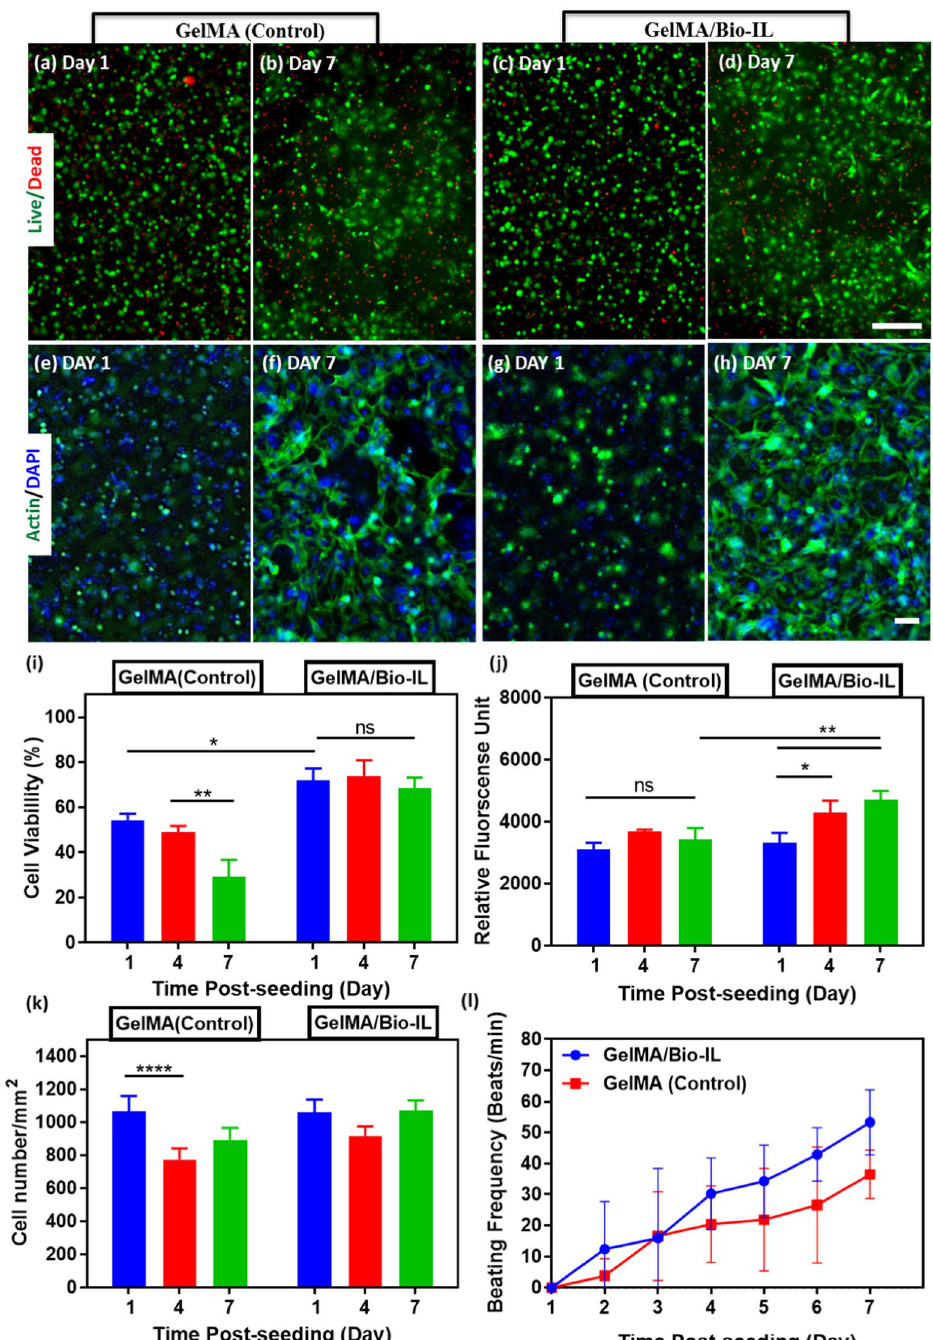
Figure 5. In vitro 3D encapsulation of cardiomyocytes (CMs) and cardiac fibroblasts (CFs) in GelMA/Bio-IL hydrogels. CMs and CFs (2:1 ratio) were 3D encapsulated inside visible light-crosslinked GelMA (control) and GelMA/Bio-IL hydrogels. Representative live/dead images from CMs/CFs encapsulated in GelMA (a , b) and GelMA/Bio-IL (c , d) hydrogels at days 1 and 7 post-encapsulation. Representative F-Actin/DAPI fluorescent images of CMs/CFs encapsulated in GelMA (e , f) and GelMA/Bio-IL (g , h) hydrogels, at days 1 and 7 post- encapsulation (scale bar = 200 μ m). (i) Quantification of cell viability for 3D encapsulated CMs/CFs at days 1, 4, and 7 post-encapsulation. (j) Quantification of metabolic activity, relative fluorescence units (RFU), using PrestoBlue assay at days 1, 4, and 7 post-encapsulation. (k) Quantification of cell proliferation based on DAPI- stained cell nuclei at days 1, 4, and 7 post-encapsulation. (l) Characterization of synchronous contraction of CMs/CFs encapsulated in GelMA (control) and GelMA/Bio-IL hydrogels over 7 days of culture. ( * p < 0.05, ** p < 0.01, *** p < 0.001 and **** p < 0.0001). All hydrogels were synthesized using 15% (w/v) final polymer concentration and 50/50 GelMA/Bio-IL ratio. Error bars indicate standard error of the means, asterisks mark significance levels of p < 0.05 ( * )p < 0.01 ( ** ), and p < 0.001 ( ***